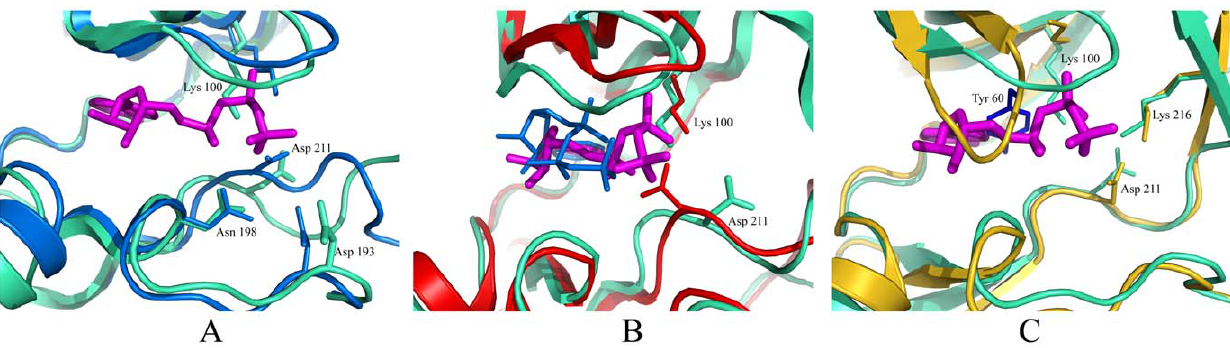
Figure 4. A comparison between the active sites of NTD RSK2 and active PKA (A), inactive NTD RSK1 (B), and inactive NTD MSK1 (C). RSK2 is shown in cyan in all panels, and only the residues of RSK2 are labeled. The active site cleft is shown with approximately the same view and zoom. ( A ) Active PKA (PDB code 1ATP) is shown in blue. The AMP-PNP molecule (magenta sticks) is depicted only from the RSK2 structure and is omitted from the PKA structure for simplification (because of a nearly overlapping conformation). The positions of most of the conserved active site residues of RSK2 are similar to those of active PKA. Those residues are Lys100 of RSK2 and Lys72 PKA located on the b 3-strand; Asn198 and Asn171 PKA from the catalytic loop; Asp211 (DFG-motif) and Asp184 PKA ; and Asp193 (RD-motif) and Asp166 PKA . ( B ) The inactive NTD RSK1 (PDB code 2Z7Q) is shown in red with the bound ATP molecule shown in blue. The overall view is rotated by , 10 u about the vertical axis relative to panels (A) and (C) to show the difference in orientation of the ribose ring and phosphate groups. Lys94 RSK1 , an analogue of the Lys100 RSK2 residue, does not interact with the phosphate group and forms a hydrogen bond with the Asp205 from the DFG-motif. Asp205 RSK1 occupies a different position compared with Asp211 RSK2 . ( C ) The inactive NTD MSK1 (PDB code 1VZO) is shown in yellow. The position of the glycine-rich loop (P-loop) is distorted in the MSK1 structure. As a result, Tyr60 MSK1 (blue) occludes the binding of the ATP molecule. A lysine from the b 3-strand, Lys81 MSK1 , is oriented perpendicularly compared with Lys100 RSK2 and forms an H-bond with the P-loop. Lys216 RSK2 and Lys200 MSK1 from the b 9-strand occupy the same